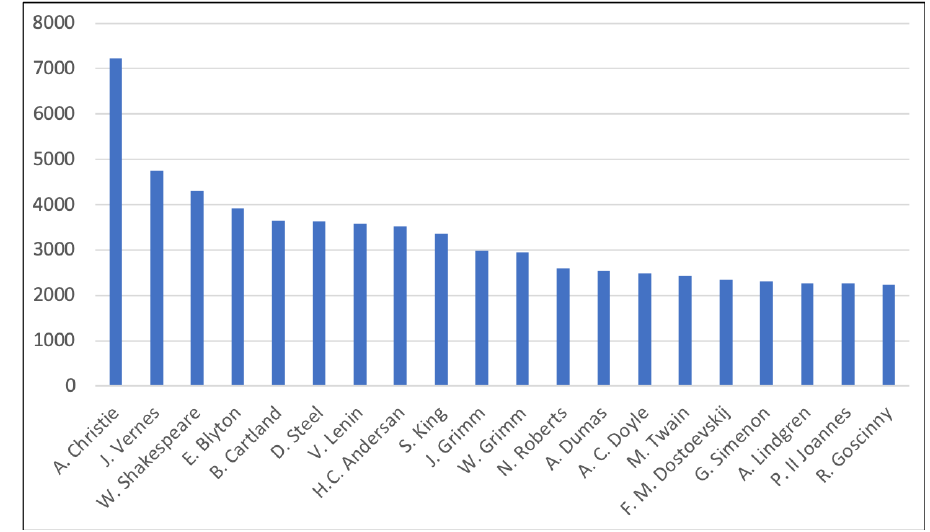
Figure 2. The world’s twenty most translated